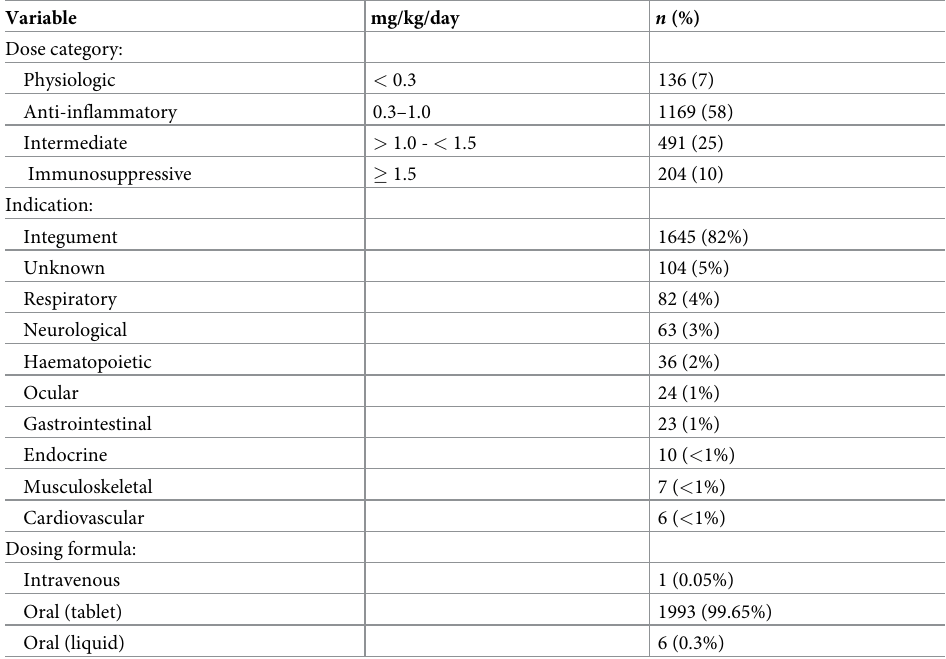
Table 3. Characteristics of prednisolone prescriptions in 2,000 dogs visiting Australian veterinary